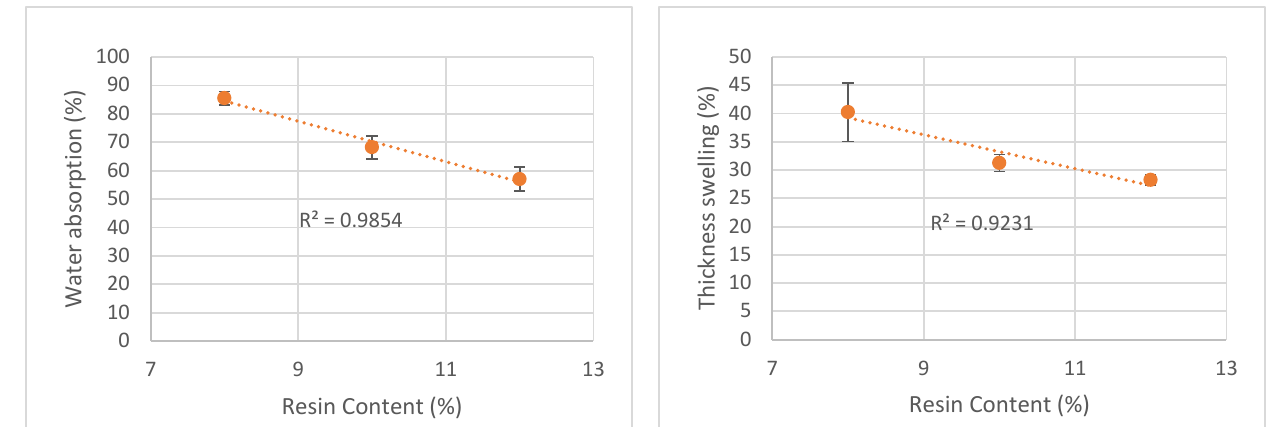
Figure 8. Correlation between water absorption and thickness swelling variation and resin content.